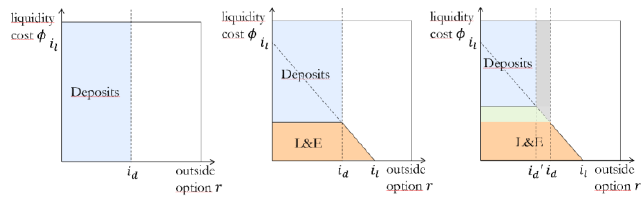
Figure 4 . Illustration of the